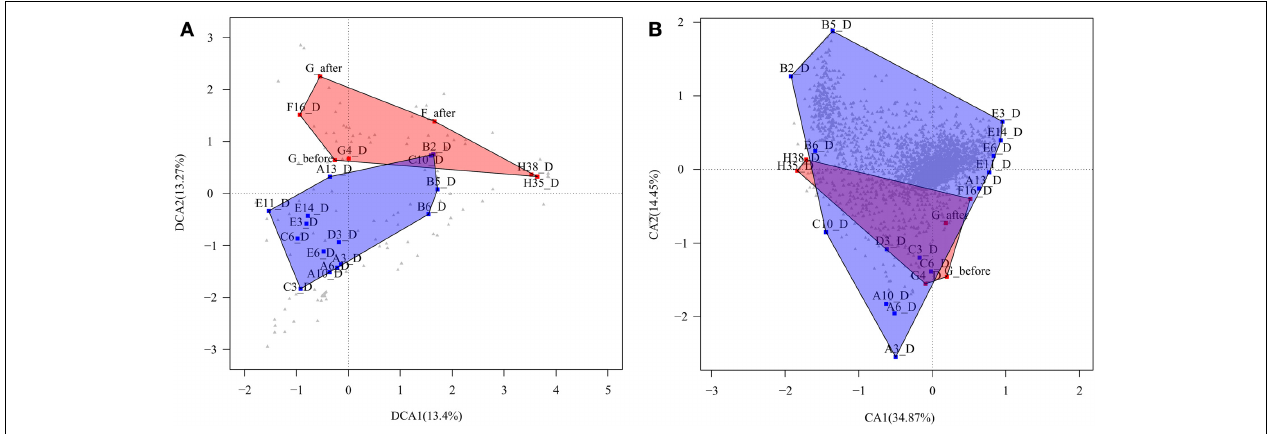
FIGURE 3 | Correspondence analyses. (A) Detrended correspondence analysis (DCA) based on taxa abundance and composition of CD + samples of patients (F, G, and H) (red square) and CD − samples of patients (A, B, C, D,